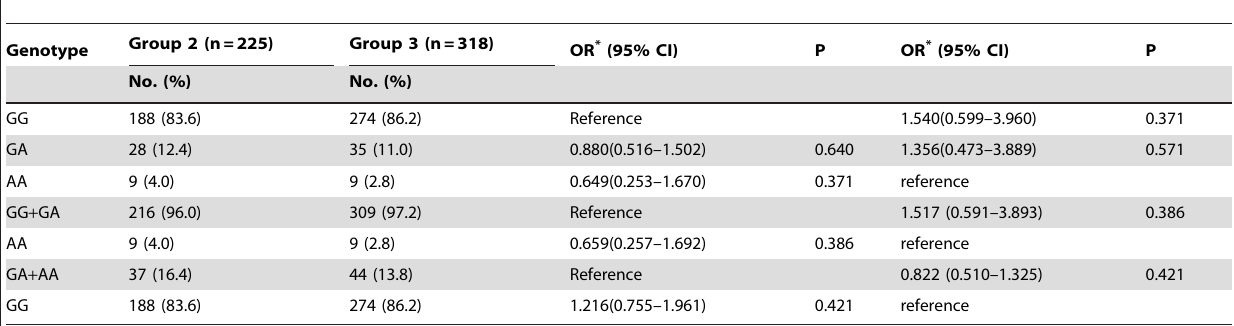
Table 3. ORs between Group 2 (HPV negative without cervical cancer) and Group 3 (HPV negative without cervical cancer).